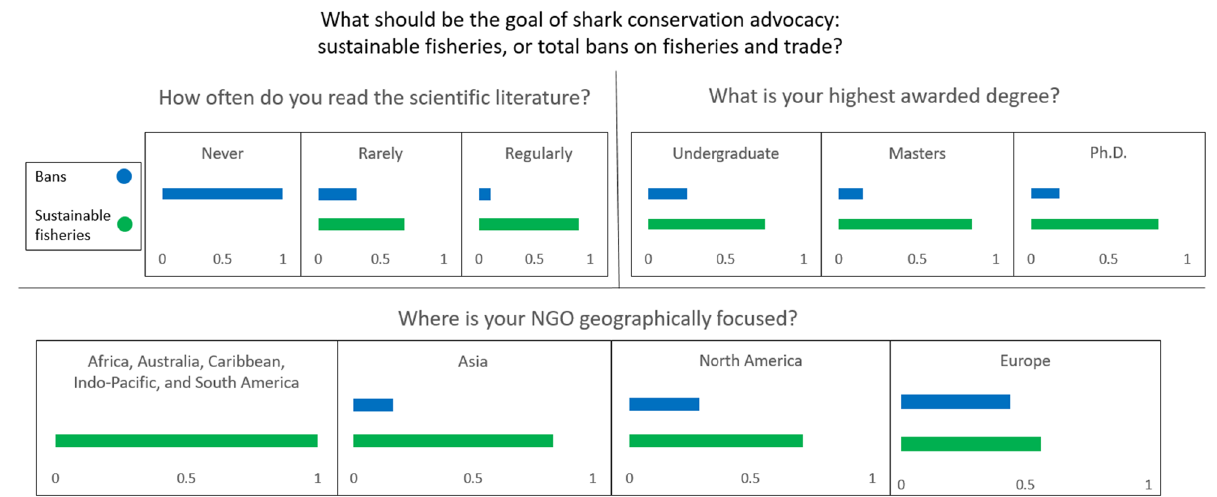
Figure 4. Proportion of environmental advocate respondents who agree with the statement that sustainable fisheries (as compared with bans on all fishing and trade) should be the goal of shark conservation, broken down by regularity of reading the literature, highest degree earned, and geographic area of